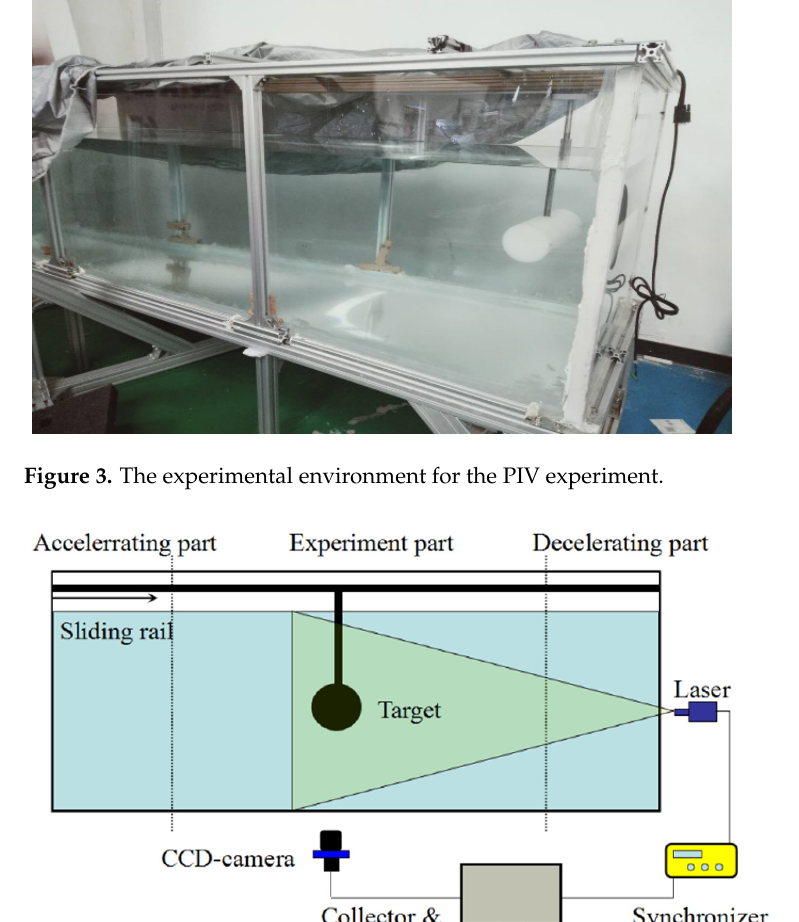
Table 1. Some key parameters used in the PIV experiment.